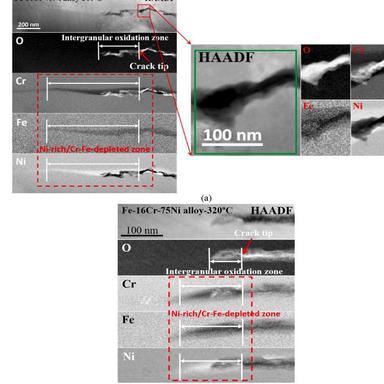
HAADF images and qualitative EELS elemental maps of representative SCC crack tips prepared from Fe-16Cr-76Ni alloy tested at (a) 360 ◦C and (b) 320 ◦C.